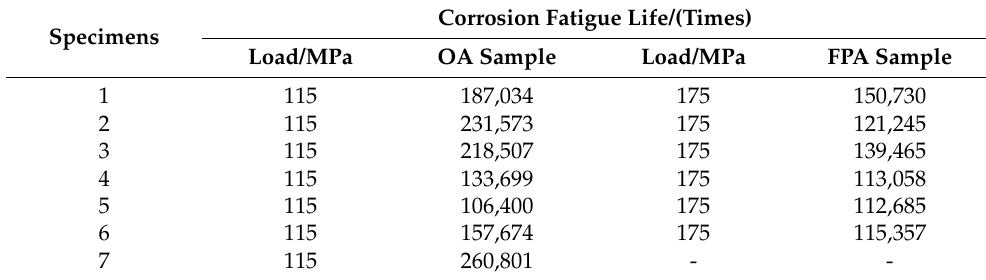
Table 5. Corrosion fatigue life of specimens in salt-spray